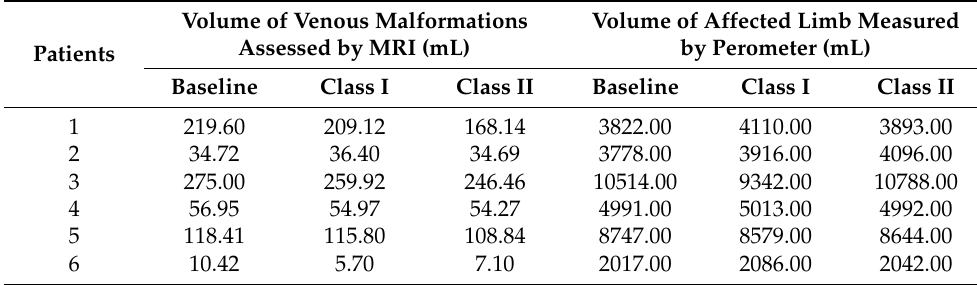
Table 4. The volume of venous malformations/affected limbs of each patient at baseline and during wearing compression stockings of class